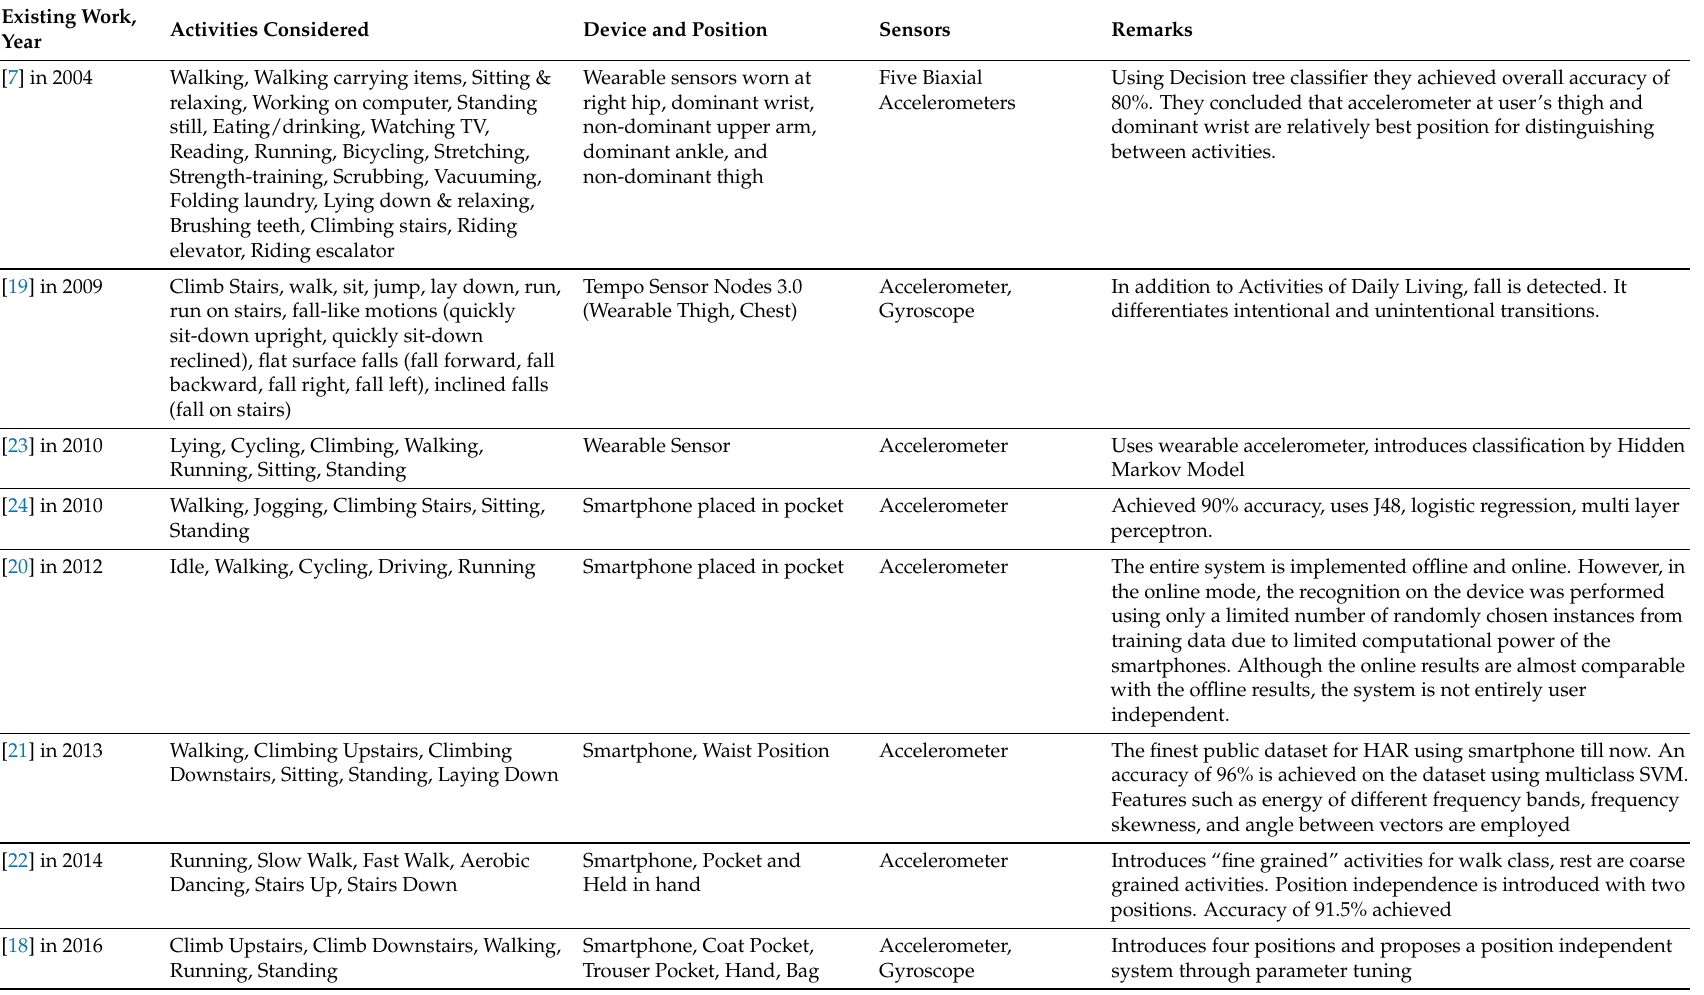
Table 1. Comparison between state-of-the-art